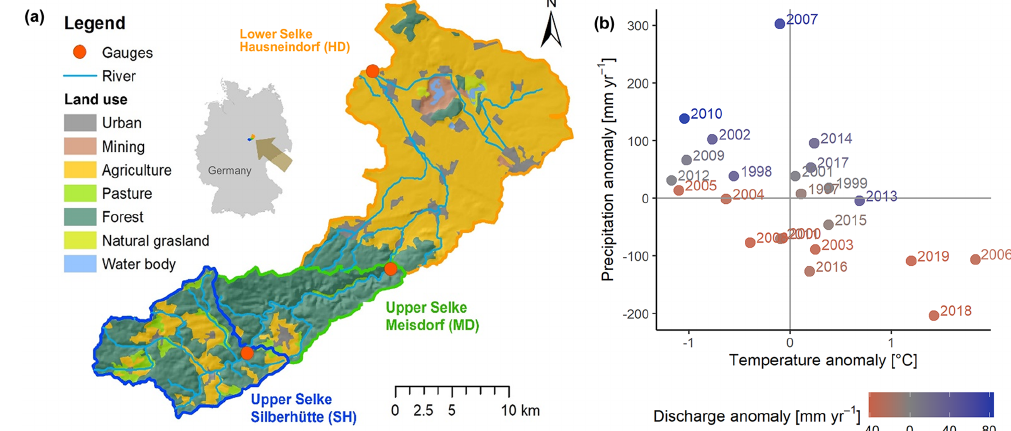
Figure 1. Study site and long-term hydro-meteorological conditions. (a) Land use map of the Selke catchment with its three gauging sta- tions (SH (Silberhütte), MD (Meisdorf), and HD (Hausneindorf)). (b) Climatic anomalies in the Selke catchment in terms of precipitation, temperature, and discharge for the years (starting in May) 1990 to